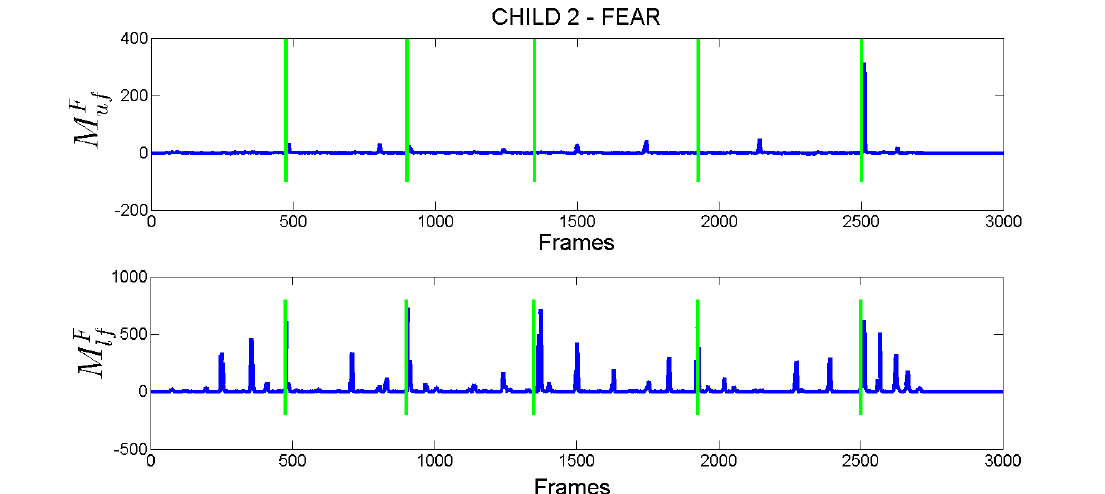
Figure 7. Measures of facial expression production ability for ASD Child 2 separately plotted for upper ( top ) and lower ( bottom ) face parts.Vertical green lines indicate the time instant in which the child was asked to produce the fear facial